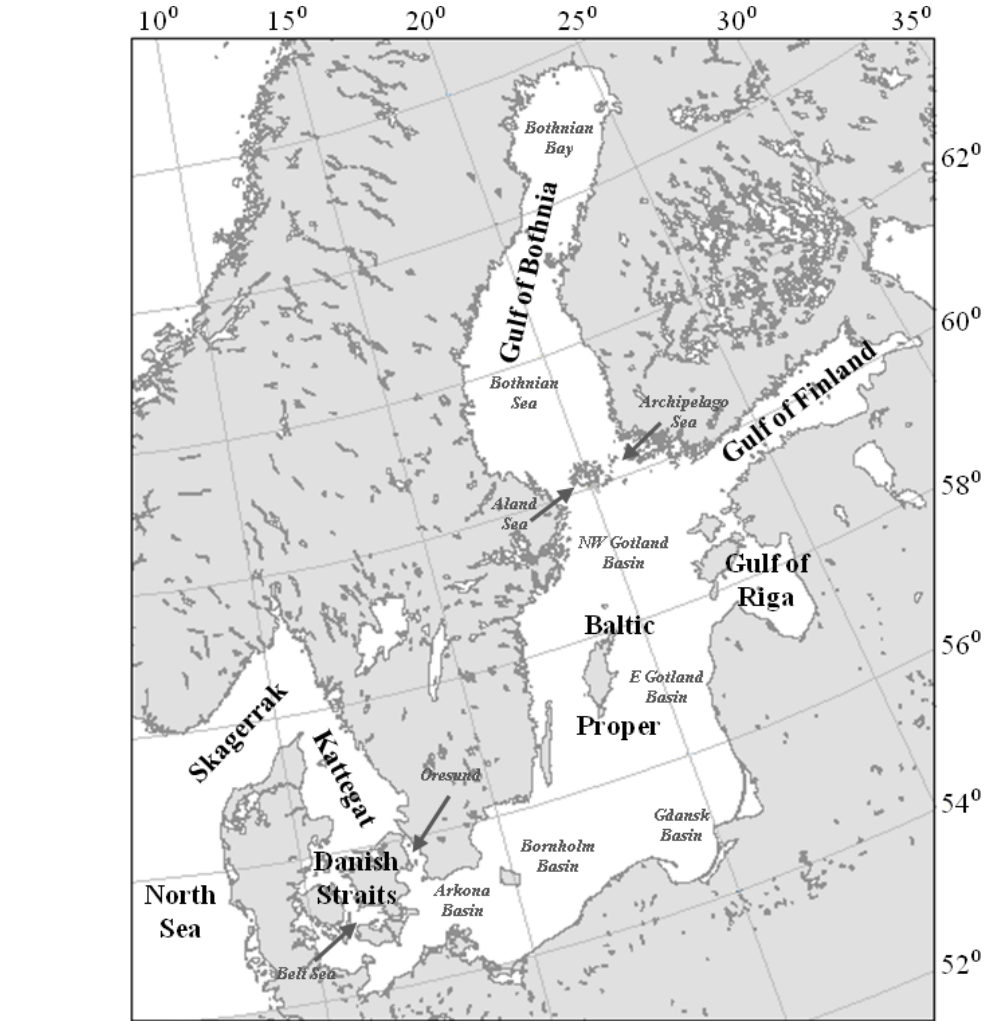
Figure 1. Map of the Baltic Sea showing its division into natural basins and sub-basins (modified after Kuli´nski and Pempkowiak, 2011).